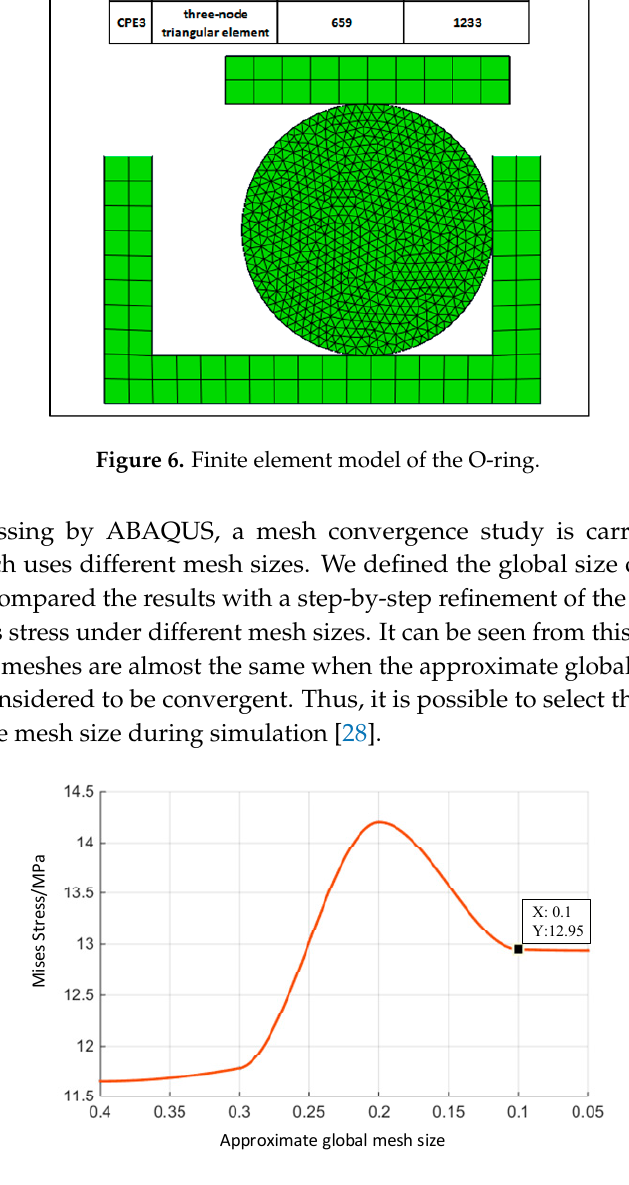
Figure 7. Mesh convergence study.